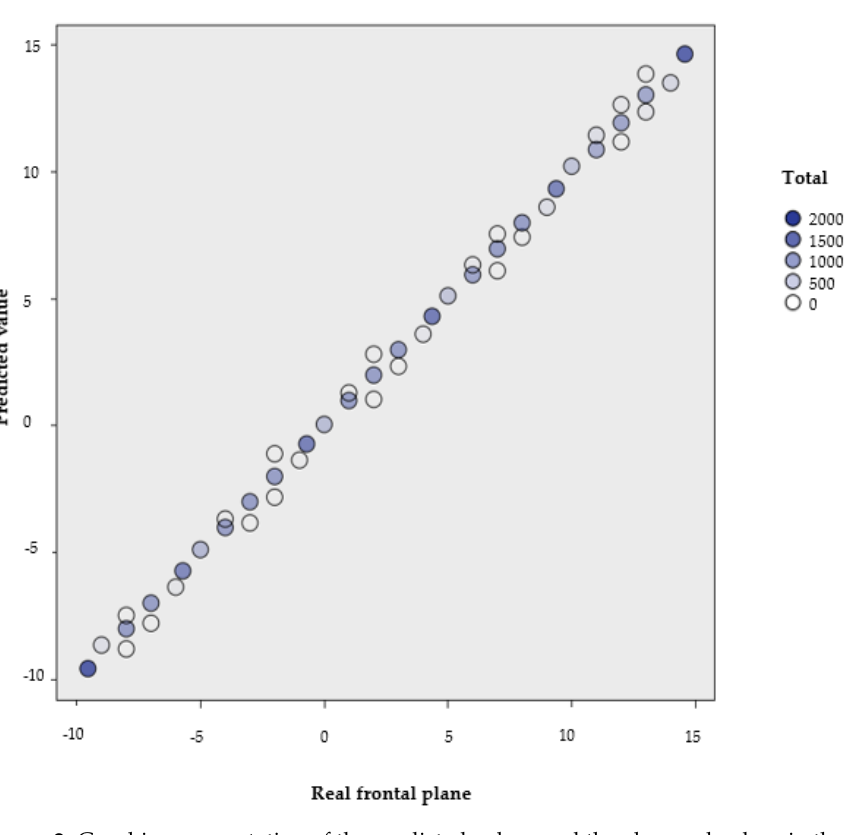
Figure 2. Graphic representation of the predicted values and the observed values in the second and definitive model (Model 2). Table 2. Results of regression Model